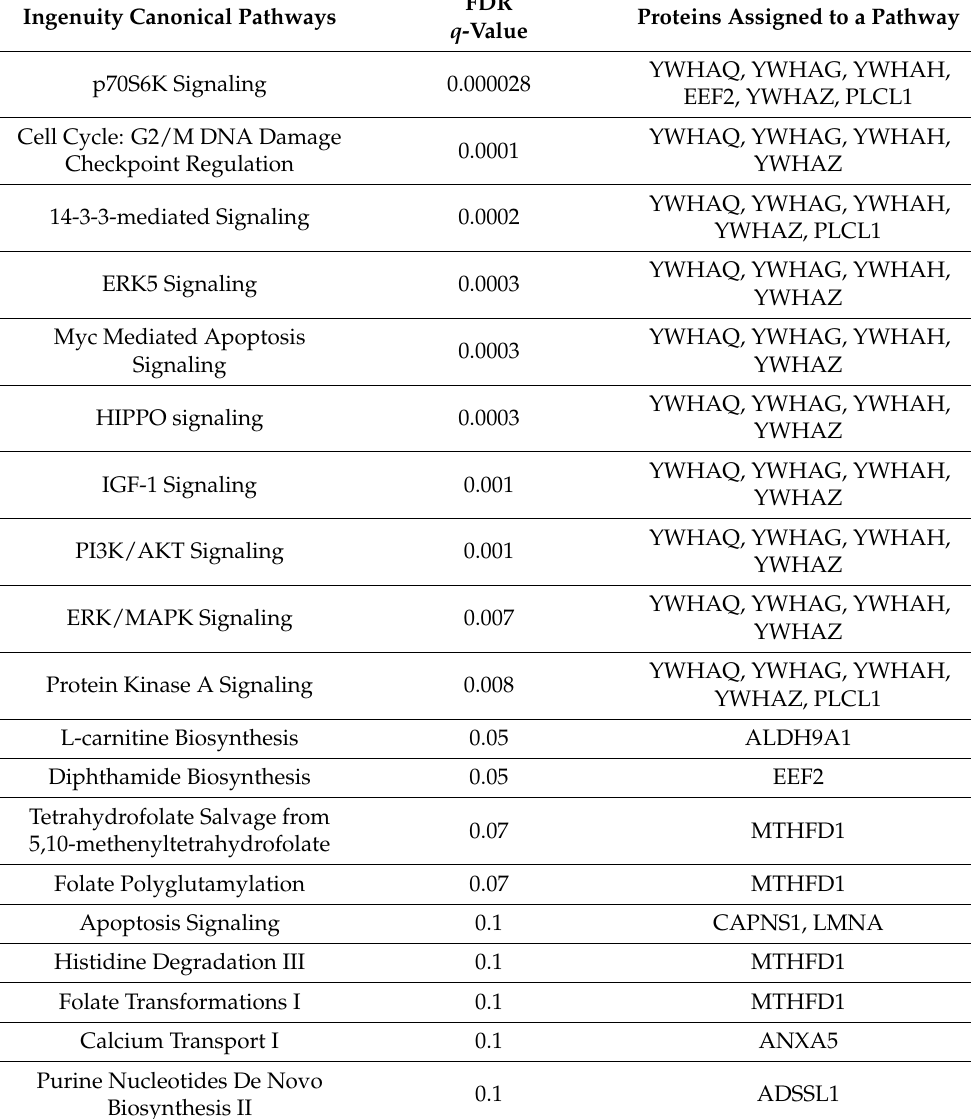
Table 3. Enriched pathways based on the 40 proteins with a significant difference between AAP and mood stabilizers using Ingenuity Pathway